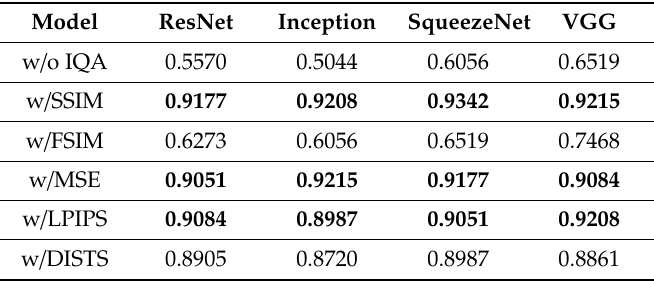
Table 7. Top-1 accuracy of image classification before and after performing the IQA in the image restoration task. Abbreviations w / o and w / represent without and with, respectively. Bold refers to the top-3 classification